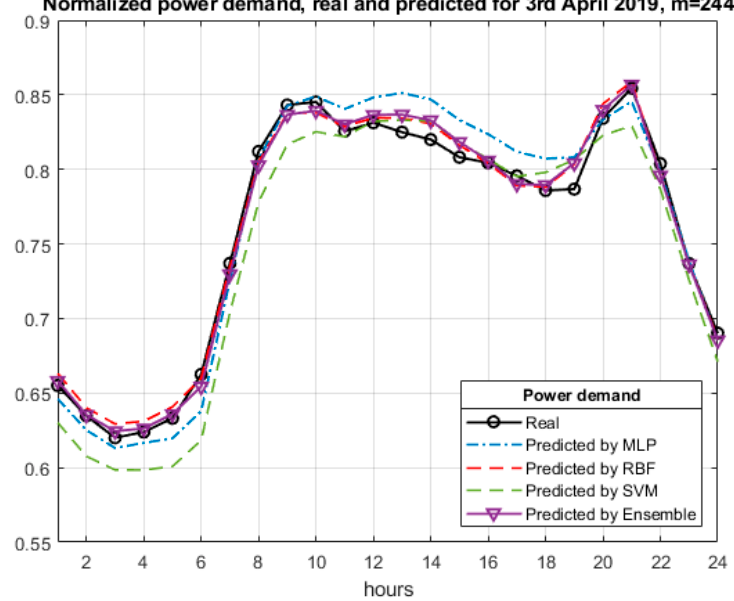
Figure 6. The distribution of the normalized 24-h power demand for 3rd April 2019, at m = 244. The solid black line represents the real power, and the solid magenta line the forecast made by the ensemble.